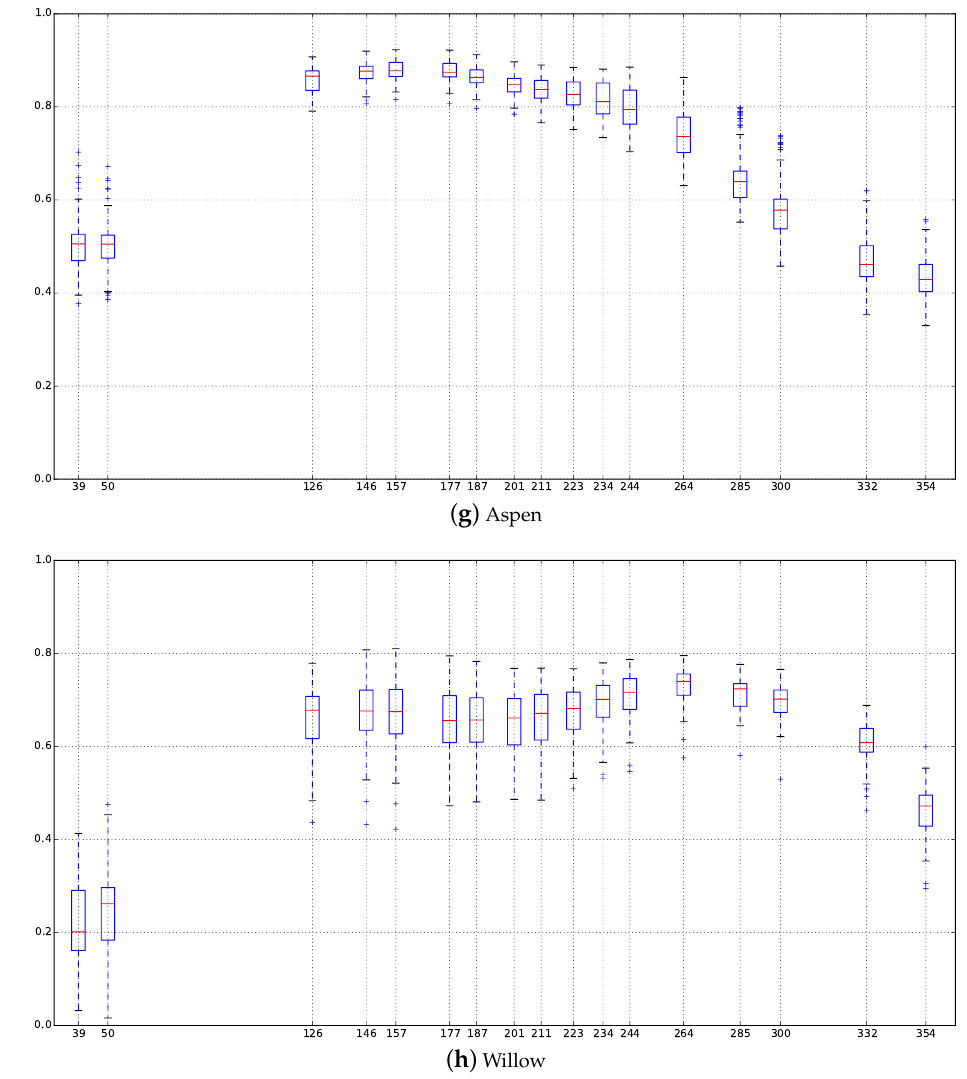
Figure C1. Seasonal dynamic of NDVI distribution among broadleaf tree species: Eucalyptus ( a ), Silver birch ( b ), Oak ( c ), Red oak ( d ), European ash ( e ), Black locust ( f ), Aspen ( g ), Willow ( h ). Boxplots (medians and the interquartile range from 1st to 3rd quartiles) are defined for each date of the year ( x-axis ) of the Formosat-2 time series of